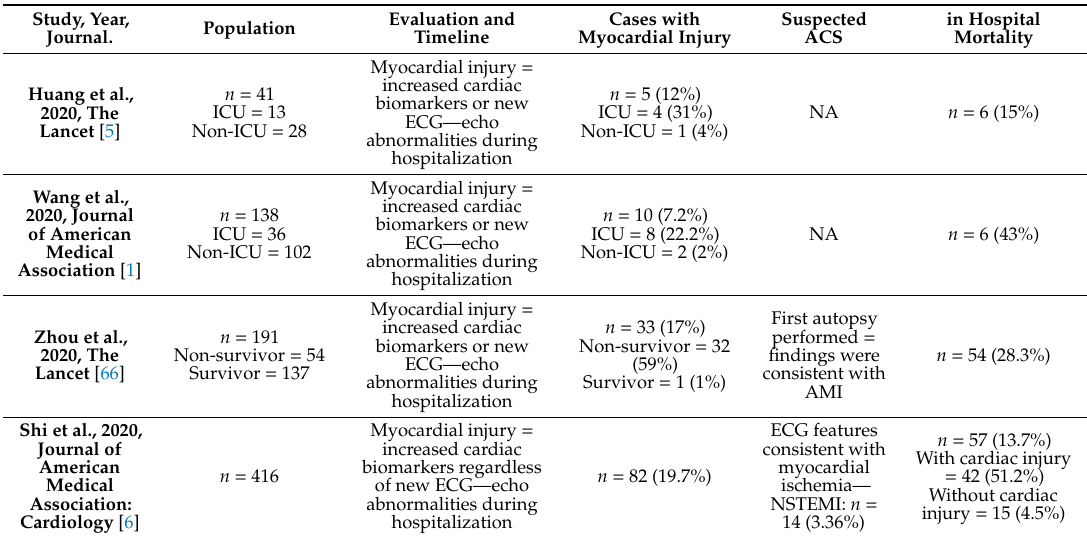
Table 3. Myocardial injury and ACS in patients with Covid-19—main